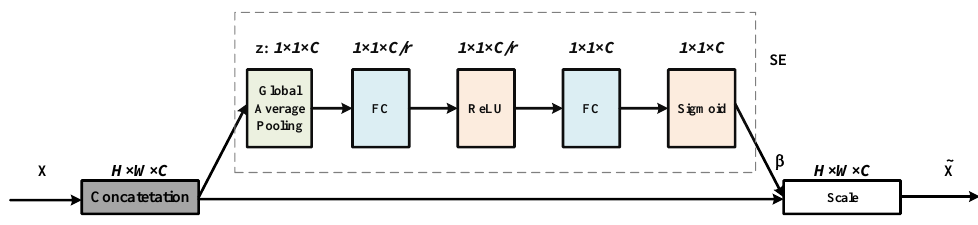
Figure 7. The architecture of the SE channel-wise attention